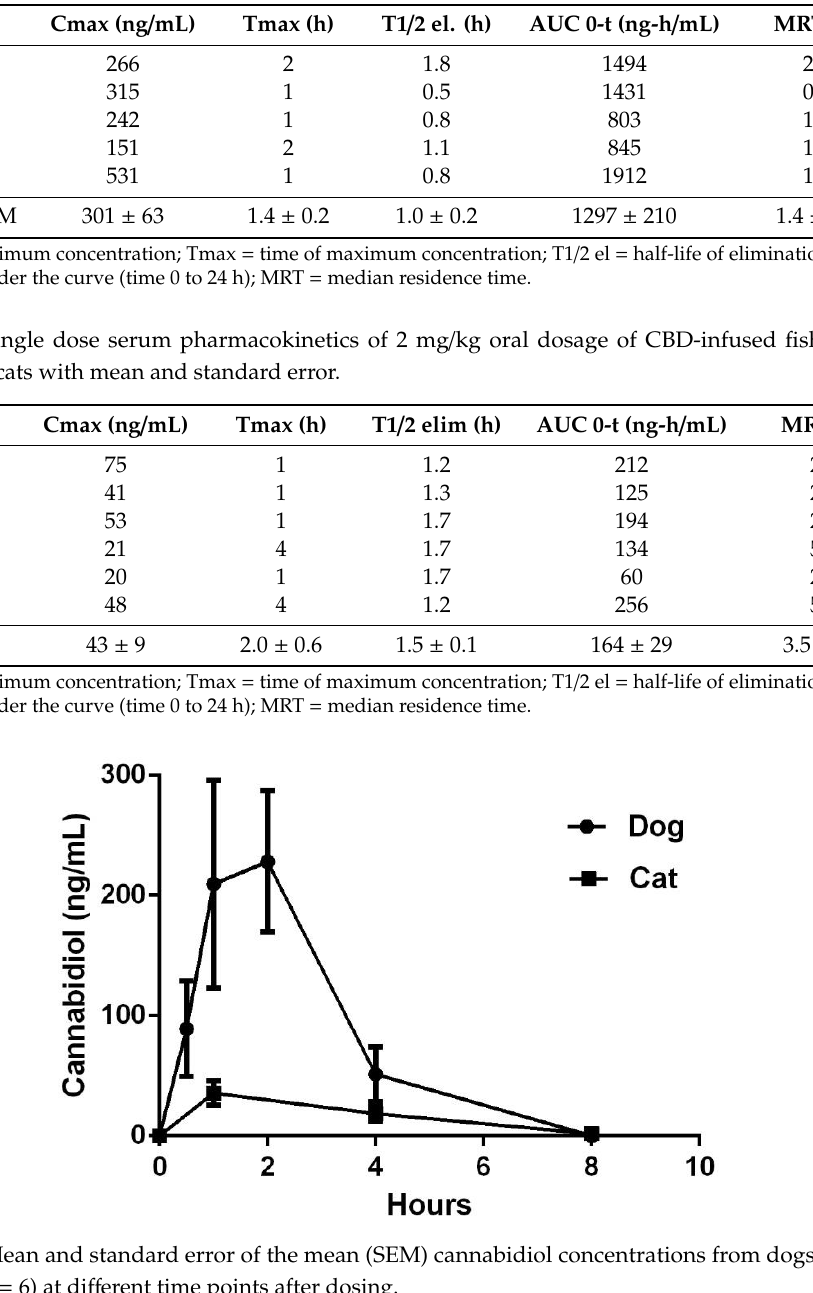
Table 1. Single dose serum pharmacokinetics of 2 mg / kg oral dose of cannabidiol (CBD) enriched soft chew of individual dogs with mean and standard error.